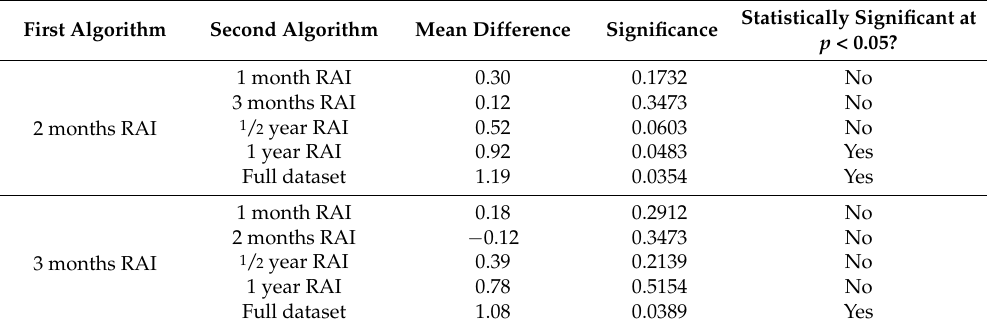
Table 2. Statistical significance tests for the results of the first experiment.